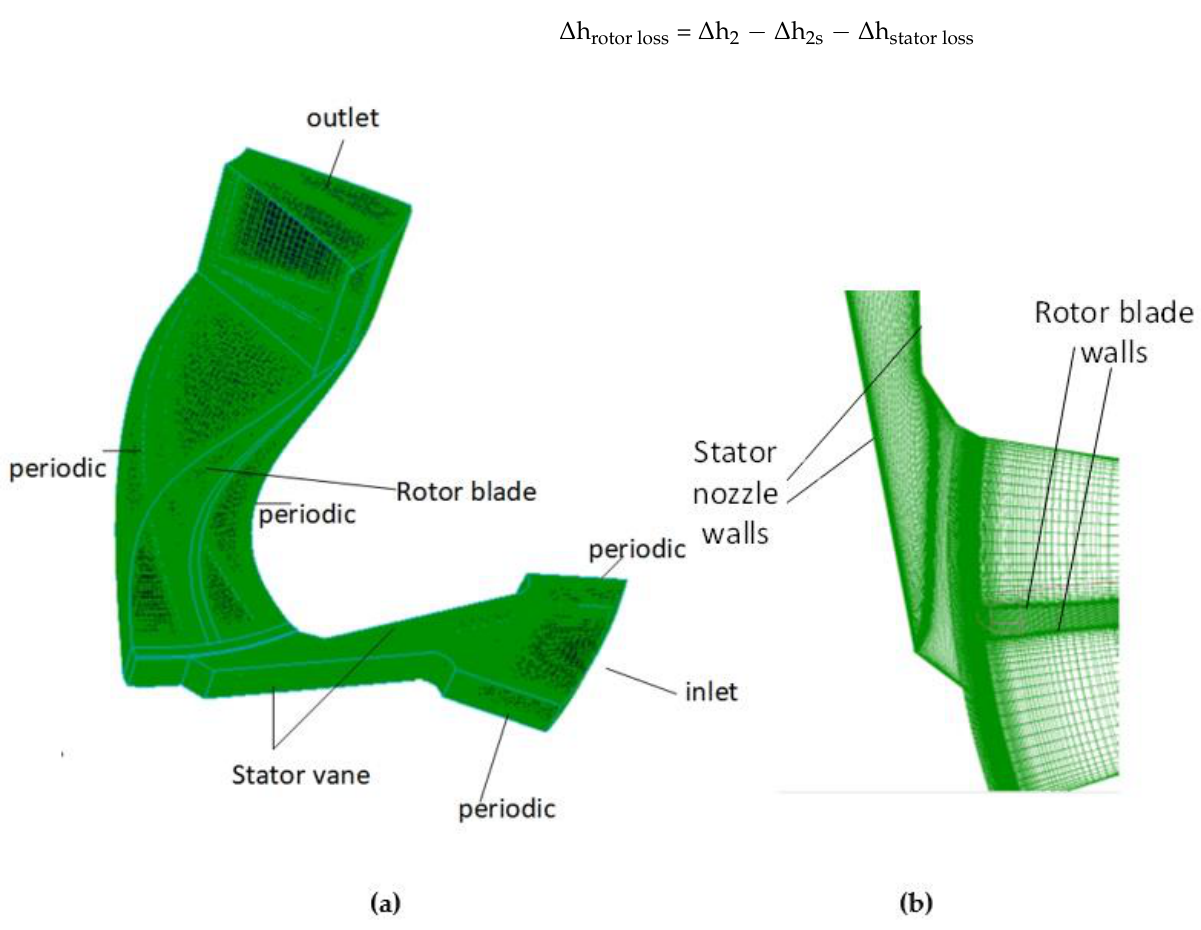
Figure 3. Example of ( a ) computational grid with one stator flow channel and one rotor flow channel modelled. ( b ) is showing an example of the grid refinement at the stator and rotor walls.